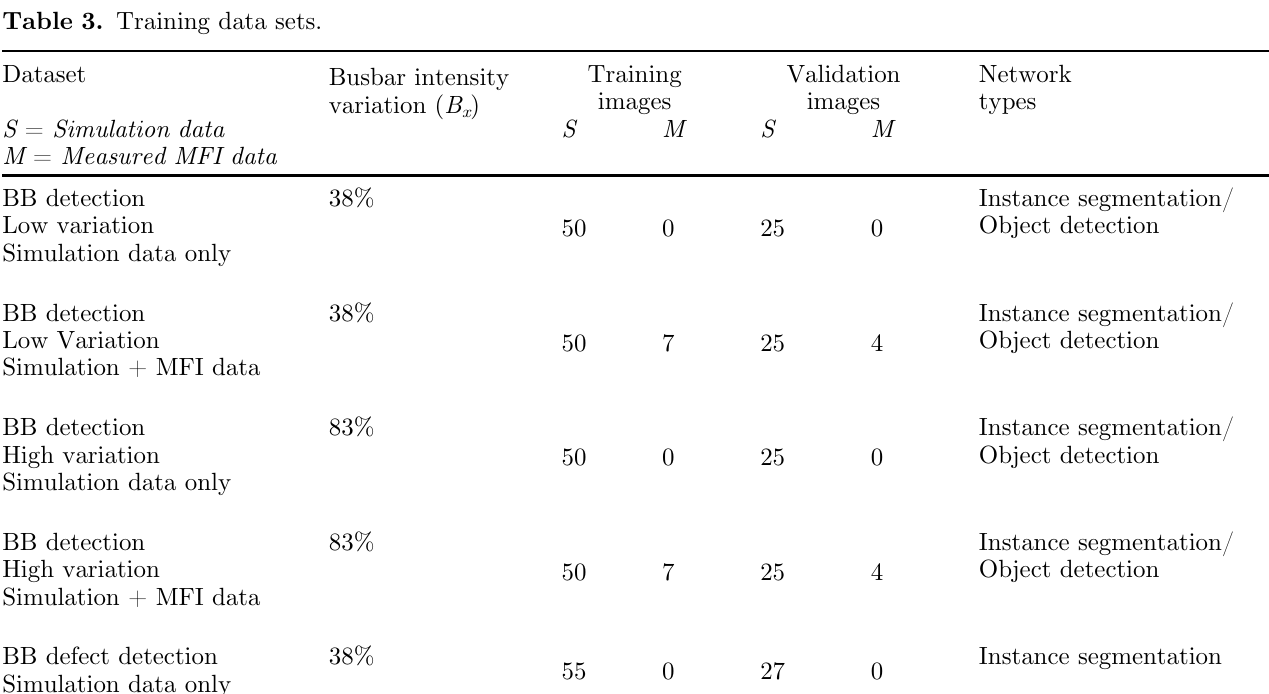
Table 3. Training data sets.